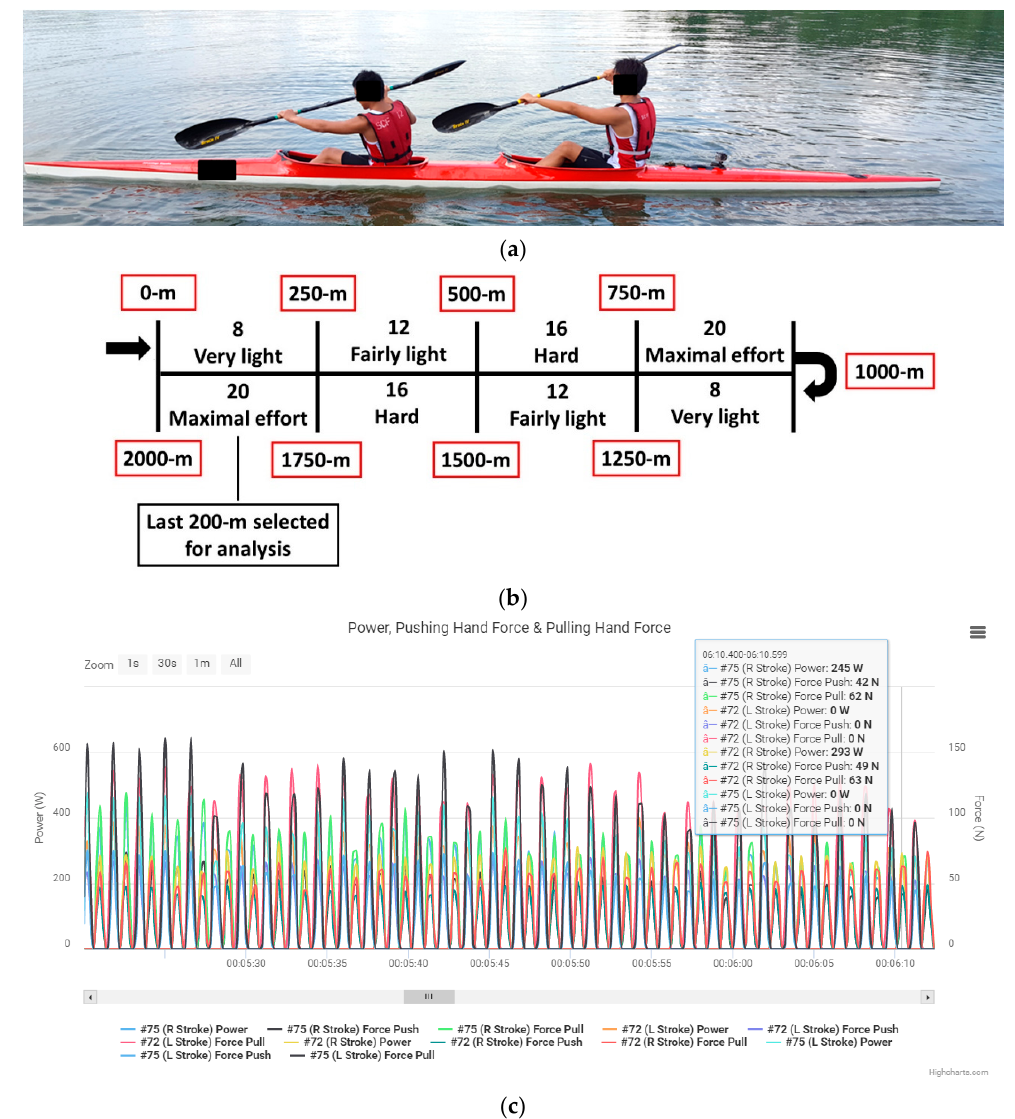
Figure 2. ( a ) K2 crew paddling on water with instrumented paddles; ( b ) step protocol with self-moderated intensities changing every 250-m; ( c ) raw data recorded using the analysis application (http://analysis.onegiantleap.co.nz).